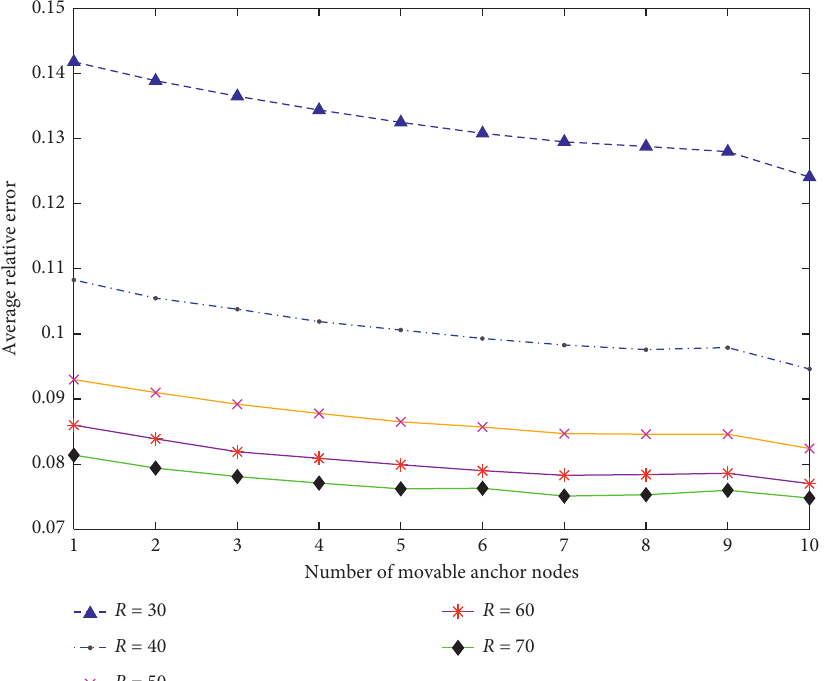
Figure 6: Average relative error of the proposed method with different number of movable anchor nodes and communication